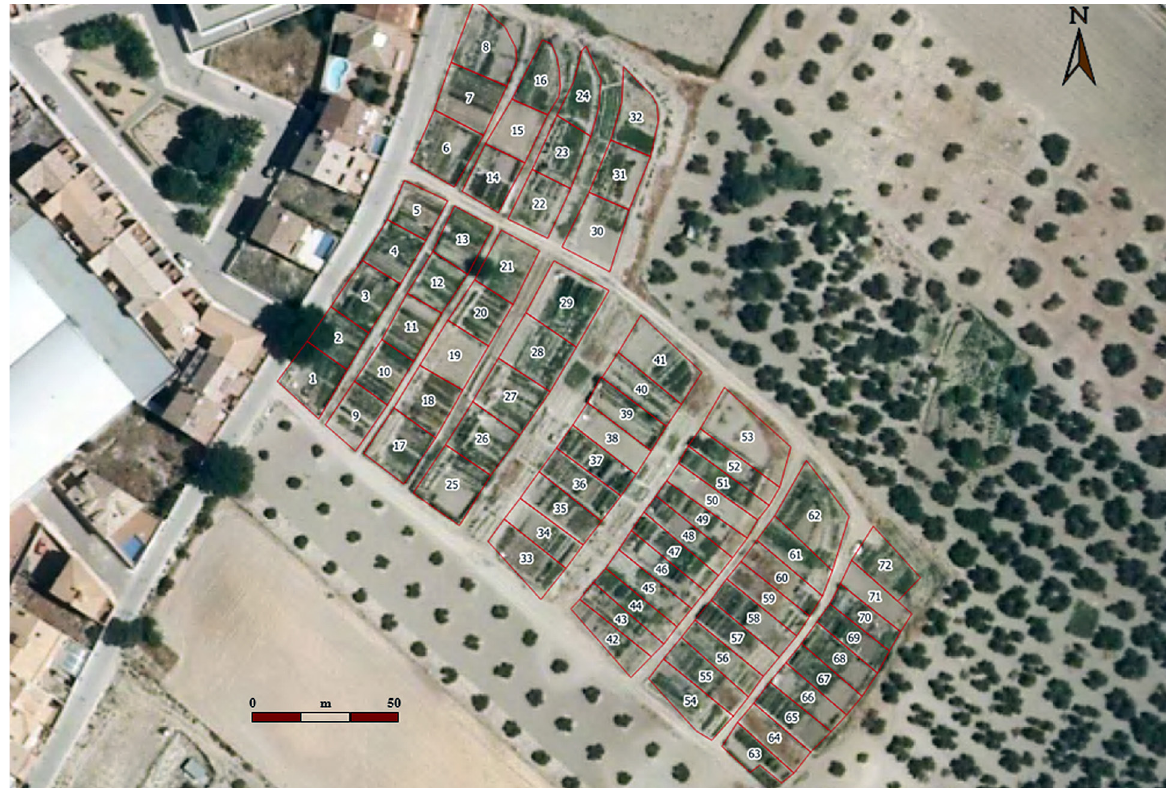
Fig. 5. Allotment gardens in Baeza in 2018. Source: own elaboration.